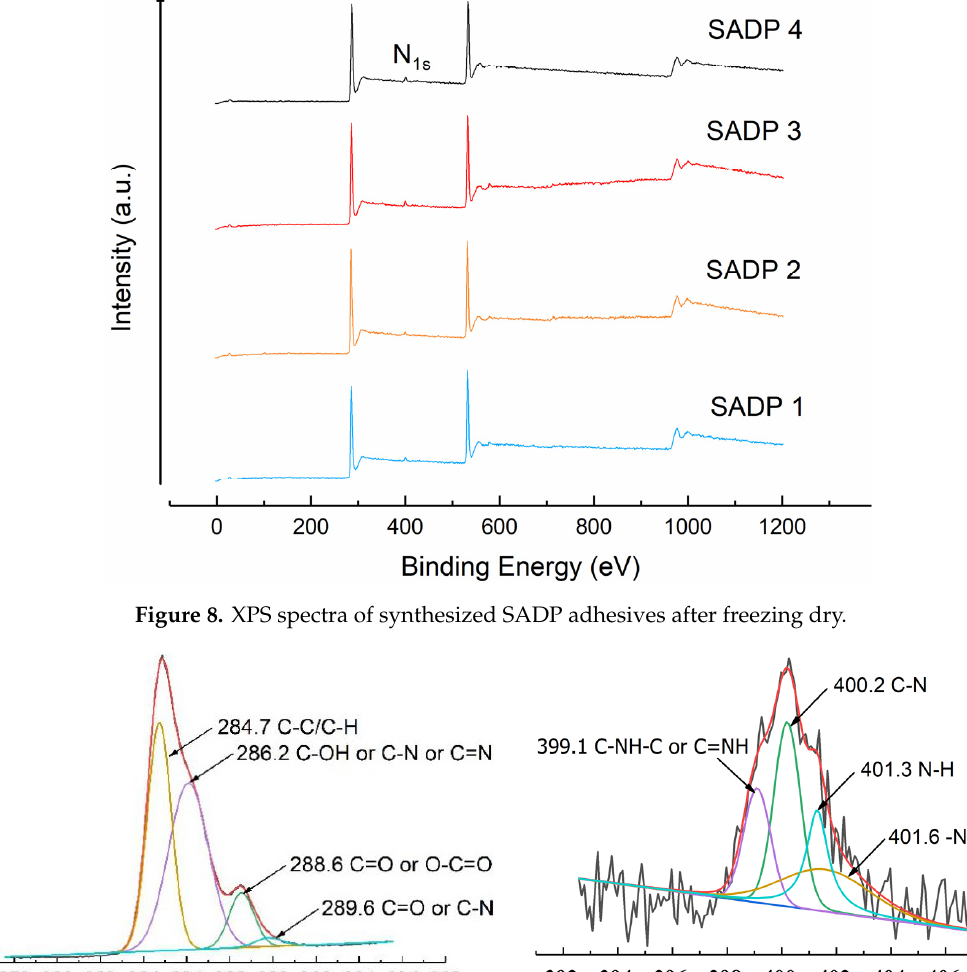
Figure 9. High ‐ resolution XPS C 1s ( a ) and N 1s ( b ) spectra for the insoluble matter of SADP 2.